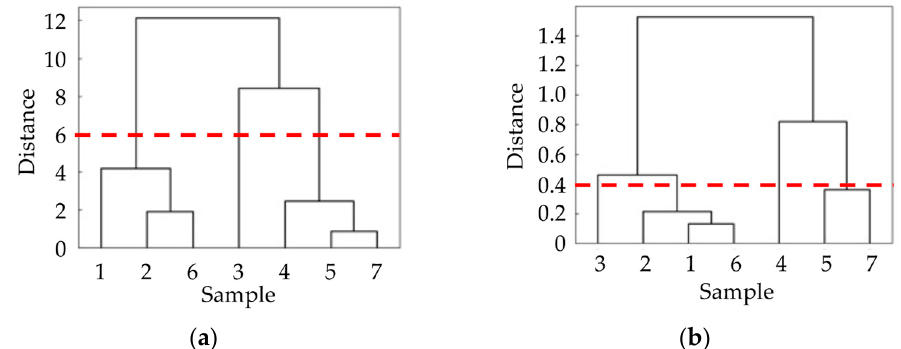
Figure 9. Results of cluster analysis: ( a ) cluster analysis of the samples based on the evaluation words obtained in the sensory evaluation and ( b ) cluster analysis of the features of the vibration information.